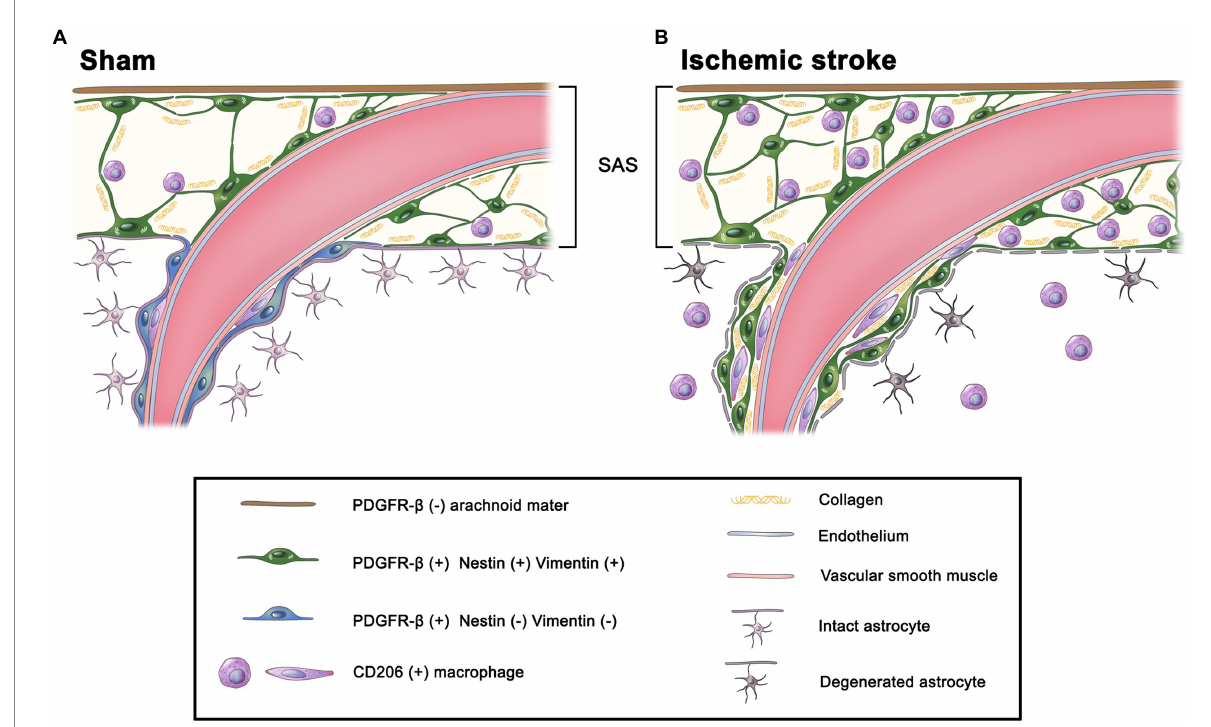
FIGURE 10 Schematic diagram of the potential infiltration route for meningeal macrophages into the infarct cortex. (A) In the sham-operated rats, meningeal macrophages are mostly localized within the leptomeninges and are occasionally located within the perivascular space of large cortical penetrating vessels, but they are not detected in the cortical parenchyma. Although PDGFR- β -positive leptomeningeal cells ensheathing leptomeningeal vessels express the intermediate filaments nestin and vimentin and are closely apposed to collagen fibrils, PDGFR- β -positive perivascular cells within penetrating cortical vessels are more flattened with loss of nestin and vimentin. (B) At 3 days after MCAO, PDGFR- β (+) perivascular adventitial cells within the penetrating cortical vessels are activated upon stroke injury, altering their morphology, adapting molecular features of leptomeningeal PDGFR- β (+) fibroblasts by expressing nestin and vimentin, and being apposed to collagen fibrils. In addition, meningeal macrophages are commonly found along the perivascular space (i.e., Virchow–Robin space) of the penetrating cortical vessels, where they are closely associated with activated PDGFR- β (+) cells. This indicates that the Virchow–Robin space is an entry route through which macrophages migrate from the leptomeninges into the infarcted